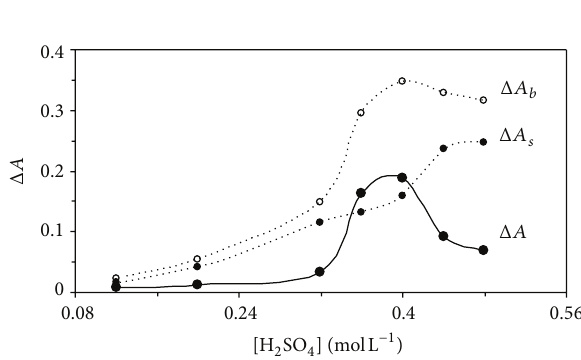
Figure 2: Effect of thionine concentration on the rate of uninhibited ( Δ𝐴 𝑏 ) and inhibited ( Δ𝐴 𝑠 ) reactions and response ( Δ𝐴 ). (Con- ditions: sulfuric acid, 0.40 mmolL −1 ; thionine, 15.0–45.0 𝜇 molL −1 ;